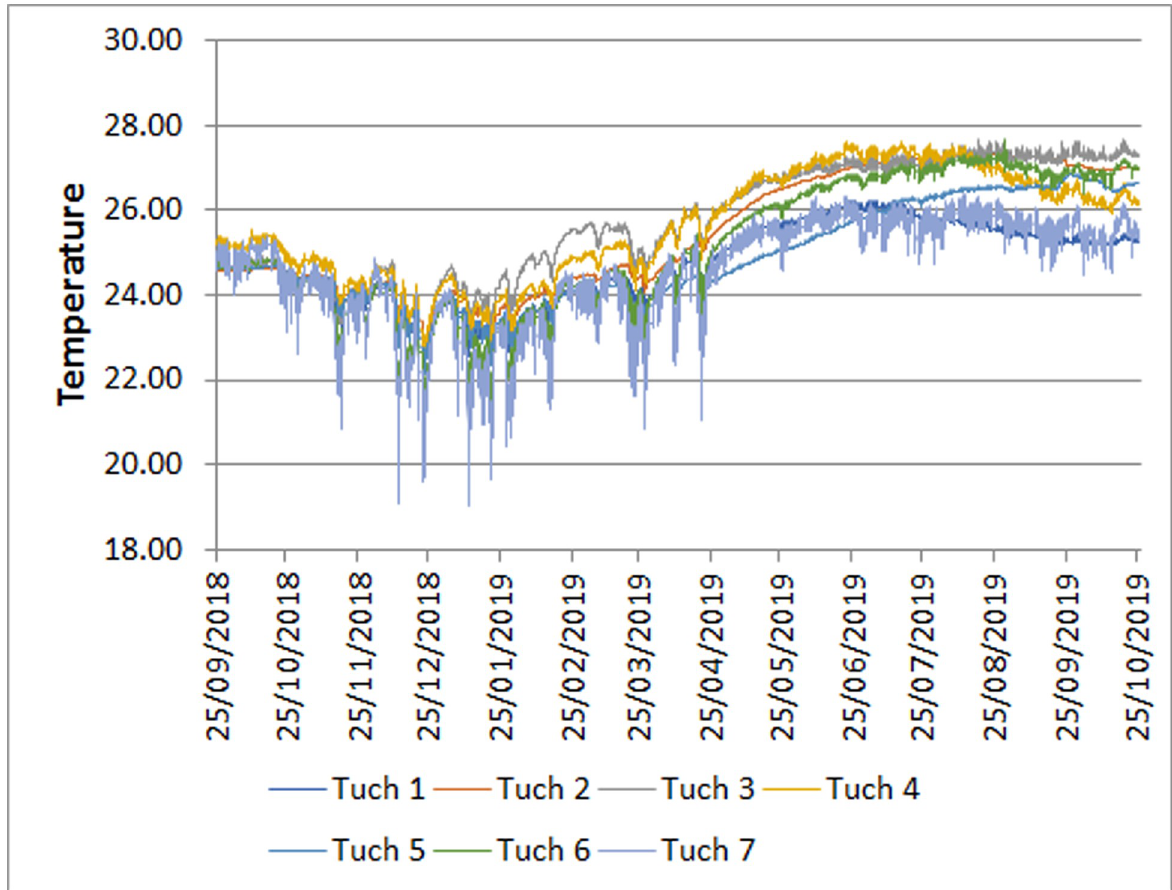
Fig 4. Plot of hourly temperature at stations in Rı´o Secreto near the Tuch entrance. All stations are plotted together for comparison. Only daily means are shown for clarity. Note that the minimums and higher variability all occur in winter.